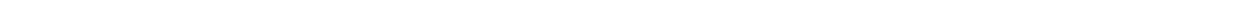
Fig. 4 Intrahepatopancreatic ducts do not contribute signi fi cantly to the developing acinar and hepatocyte lineages. a – d Immuno fl uorescence analysis of the pancreas ( a , b ) and liver ( c , d ) in 5 dpf wild type ( a , c ) and jag1b − / − ;jag2b − / − mutant embryos ( b , d , bottom panels with lfabp10: DsRed channel removed). Despite the absence of ductal cells in jag1b − / − ;jag2b − / − mutants b , d , lumen formation ( arrows ) and apical localization of ZO-1 ( red in b , green in d ) remain comparable to wild type siblings ( a , c ). Normal differentiation indicated by zymogen granule accumulation in the ptf1a :GFP + pancreatic acinar cells ( green ) and lfabp -DsRed expression ( red ) in hepatocytes. e Schematic of approach to Notch activity lineage tracing. f – i Notch active labeled H2B-mCherry + cells ( red ) in the liver are all Prox1 + ( blue ) and Hnf4a − ( green ) ( n = 12 embryos, 1,416 labeled cells counted from two different experiments ( f ), P < 0.0001). g , h In the pancreas, nearly all H2B-mCherry + cells ( red ) co-express Nkx6.1 ( blue ) and are ptf1a :GFP − ( green ) ( n = 24 embryos, 1,586 labeled cells counted from 3 different experiments, P < 0.0001) g Only a few H2B-mCherry + cells that lack Nkx6.1 but are ptf1a :GFP + were observed ( arrows , h . n = 4/24 embryos, 12 cells total). i Graph summarizing numbers of Notch active labeled H2B-mCherry + cells found in hepatocytes versus intrahepatic duct (IHD) cells and acinar pancreas versus intrapancreatic duct (IPD) cells. Representative samples; a – d , n = 4 each. Scale bars 25 μ